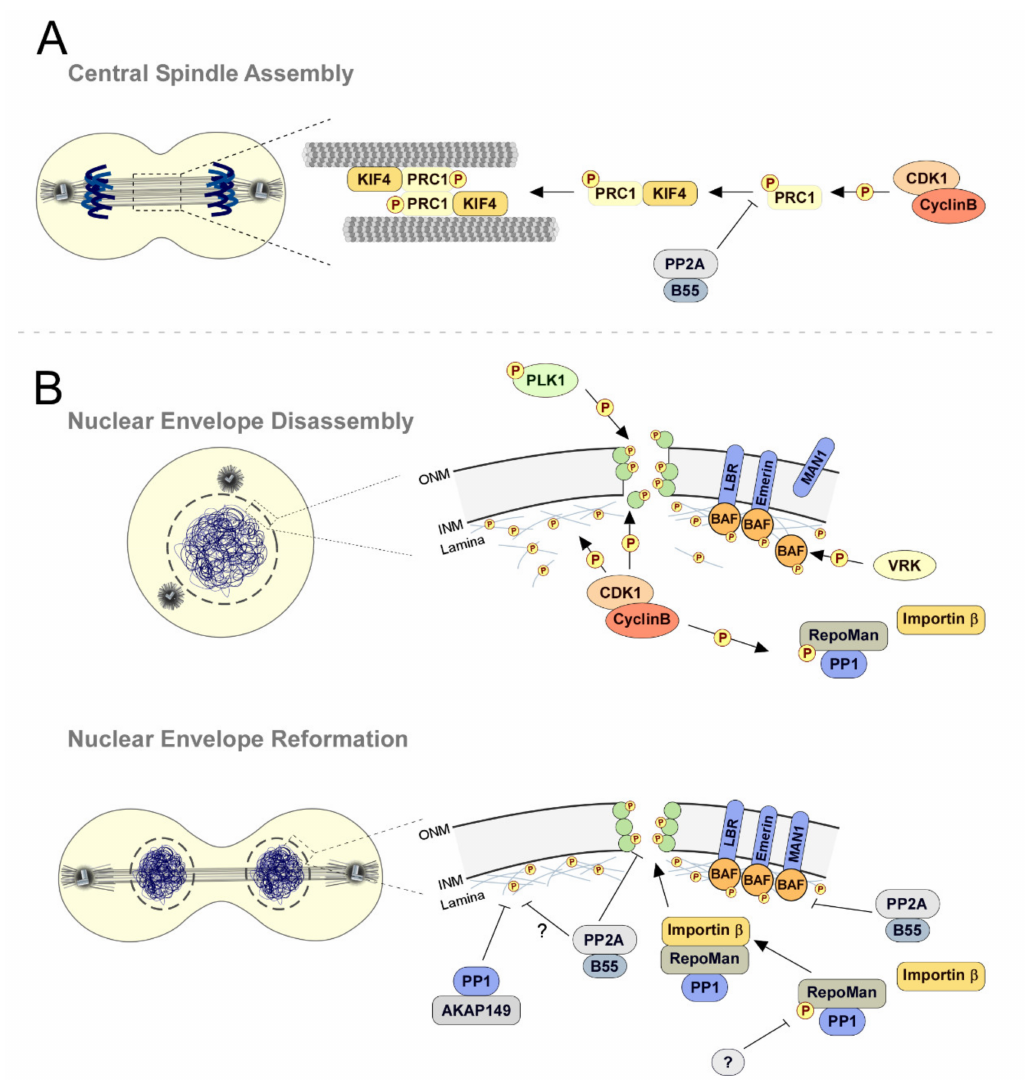
Figure 7. PP2A-B55 and PP1 activities orchestrate mitotic exit. ( A ) Formation of the central spindle during anaphase relies on the activity of PRC1. Phosphorylation of PRC1 by CDK1-Cyclin B precludes its microtubule bundling activity. Dephosphorylation of PRC1 is catalyzed by PP2A-B55 during anaphase and enables PRC1 interaction with the kinesin motor KIF4, its consequent translocation to the plus ends of antiparallel interdigitating microtubules, and the protein homodimerization required for its microtubule bundling activity and thereby for the assembly of the central spindle. ( B ) Reformation of the nuclear envelope and associated nuclear pore complexes around chromatin occurs at the end of mitosis. This requires removal of the multiple phosphorylations that were catalyzed during mitotic entry to promote the disassembly of the nuclear envelope and of nuclear pore complexes. During late anaphase/telophase, PP2A-B55-mediated dephosphorylation of BAF restores its interaction with chromatin and with components of the inner nuclear membrane (INM). PP2A-B55 might also target Lamin and several nucleoporins to direct their assembly into the nuclear envelope. Multiple pools of PP1 cooperate with PP2A-B55 to promote nuclear envelope reformation. AKAP149 localizes PP1 on the assembling nuclear envelope, where it dephosphorylates Lamin B to promote its polymerization and accelerate nuclear lamina assembly. Repo-Man targets PP1 γ to the periphery of late anaphase chromosomes. The N-terminus of Repo-Man directly mediates the recruitment of Importin- β to control early nuclear envelope formation and nucleoporin